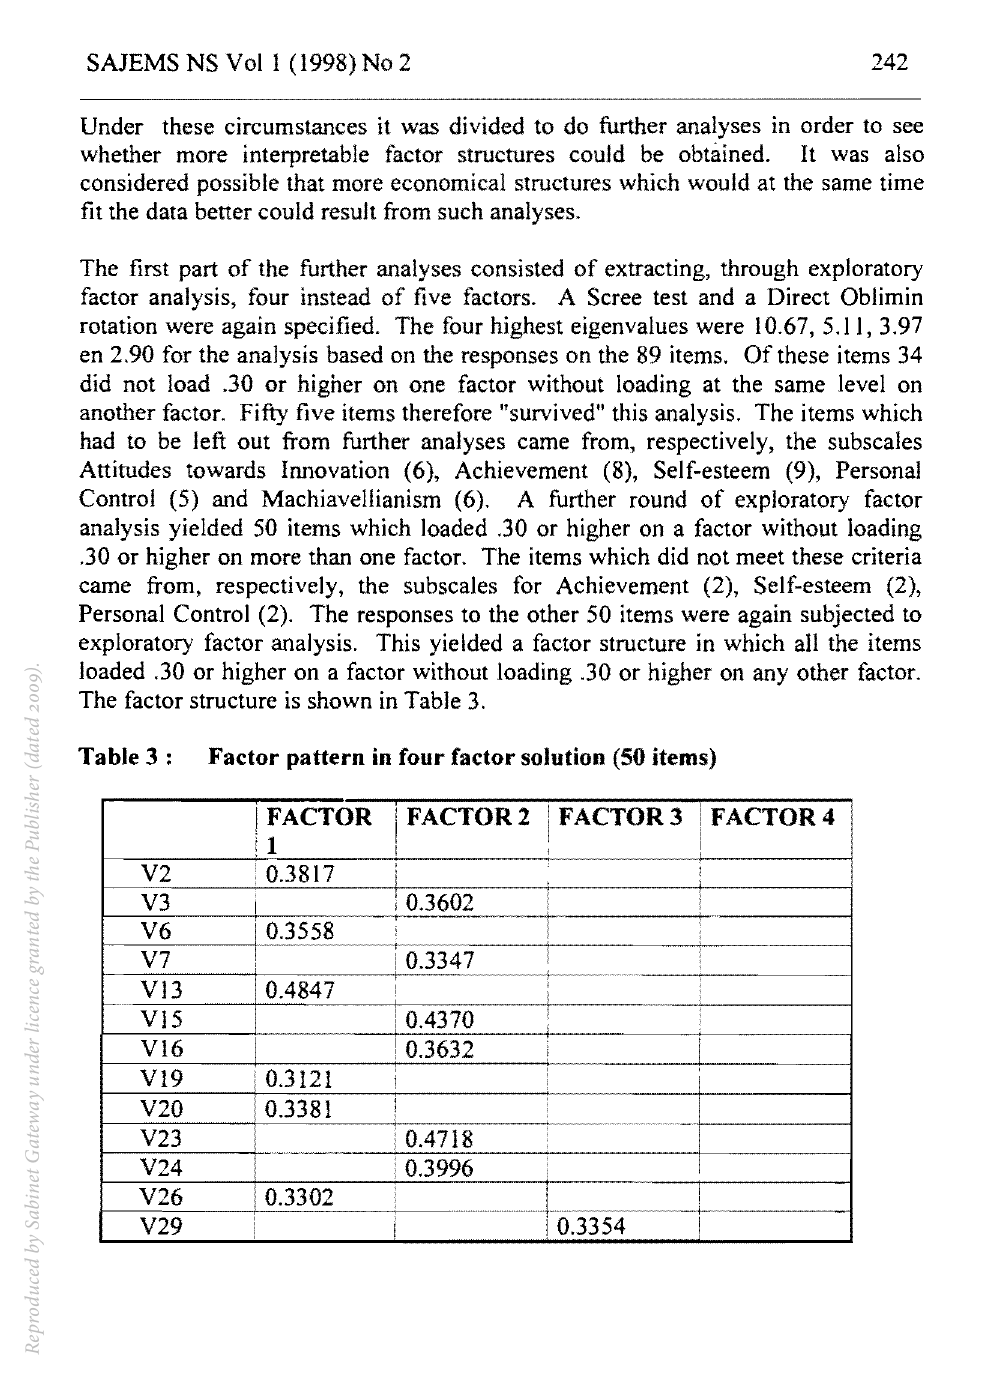
Factor pattern in four factor solution (50